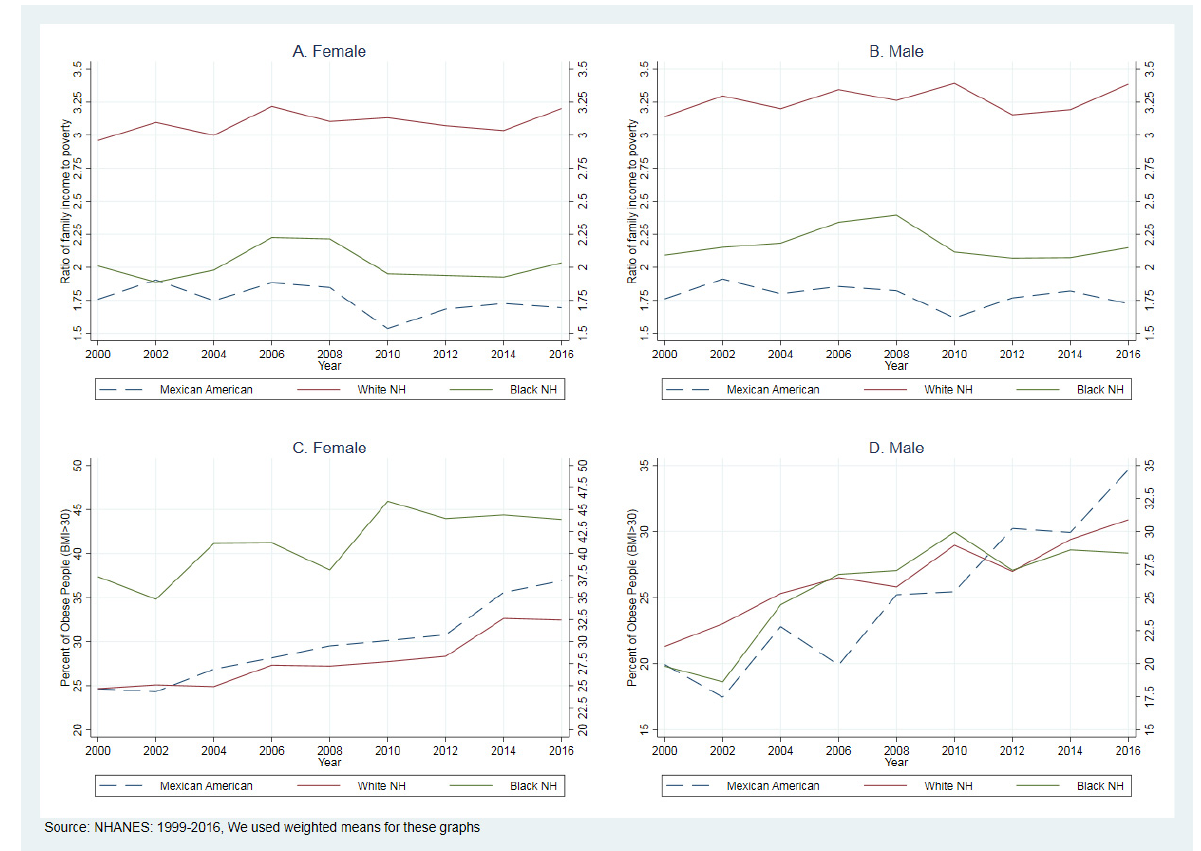
Figure 1. Comparing the ratio of family income to poverty and percent of obese people (BMI > 30). In Figure 2a panel A, the solid blue line plots the distribution of income in non-obese WNH women; the dash-red line shows the distribution in WNH obese women. The blue line stays over the red line for about 30% of the population and closer to the perfect equality line, which means lesser income inequality within non-obese (GC: 0.269) and greater inequality within obese women (GC: 0.301). Interestingly, there was a different pattern in the BNH population. As presented in panel B, obese BNH women suffered less from income inequality than non-obese (GC: 0.380 vs. 0.392). The red-dash-line stays over the solid blue line for about 50% of the population and closer to perfect equality. Panel C does not show many differences between obese and non-obese MA women (GC: 0.410 vs. 0.395). The last panel (Panel D) compares income inequality between obese WNH, BNH, and MA; overall, BNH women suffered more from obesity than WNH and MA obese women. As presented, BNH women and MA women suffered more from income inequality than WNH. In obese women, WNHs’ lower 25% of the population observed 8.1% of income, BNH followed 6.2% of income, and MA observed 6.4% of